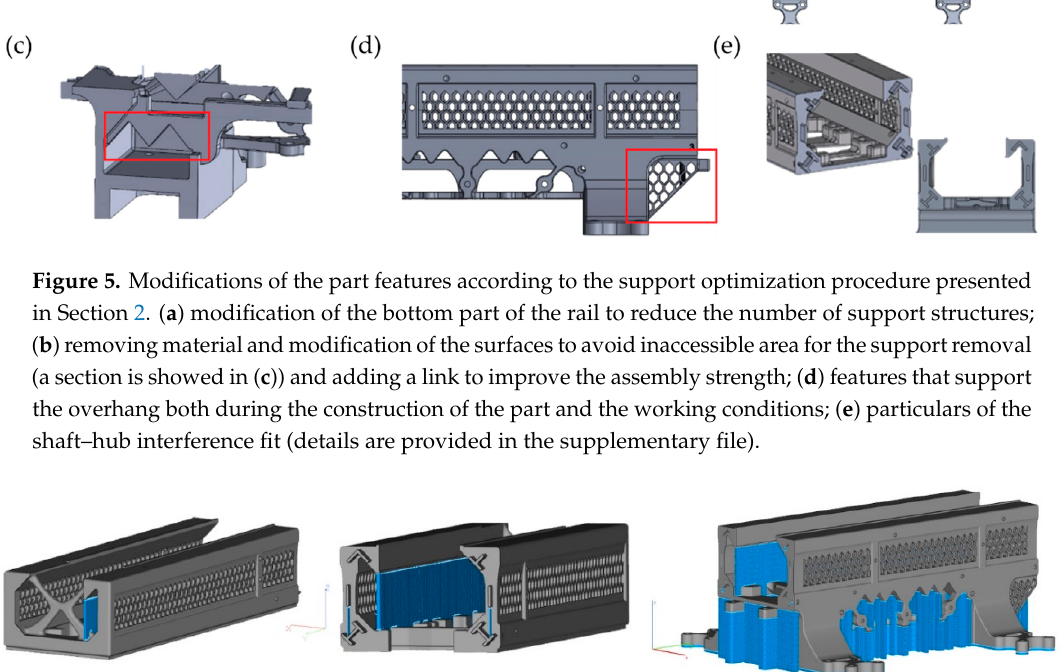
Figure 7. Comparison of the maximum displacements between the original and the new design. The maximum displacement is registered as the extremity of the probe. The slight difference in the displacements values between the two designs demonstrates that the stiffness of the system has been preserved while the material efficiency has been improved. 4.2. Bracket Design As already mentioned, the redesigning process had the aim of designing a bracket that would satisfy the original requirement, in terms of displacement, while maintaining its original weight. In order to maintain the original rail assembly operational flow, the coupling areas were constrained with other systems to avoid modifications as a result of the redesign. Some other surfaces were also